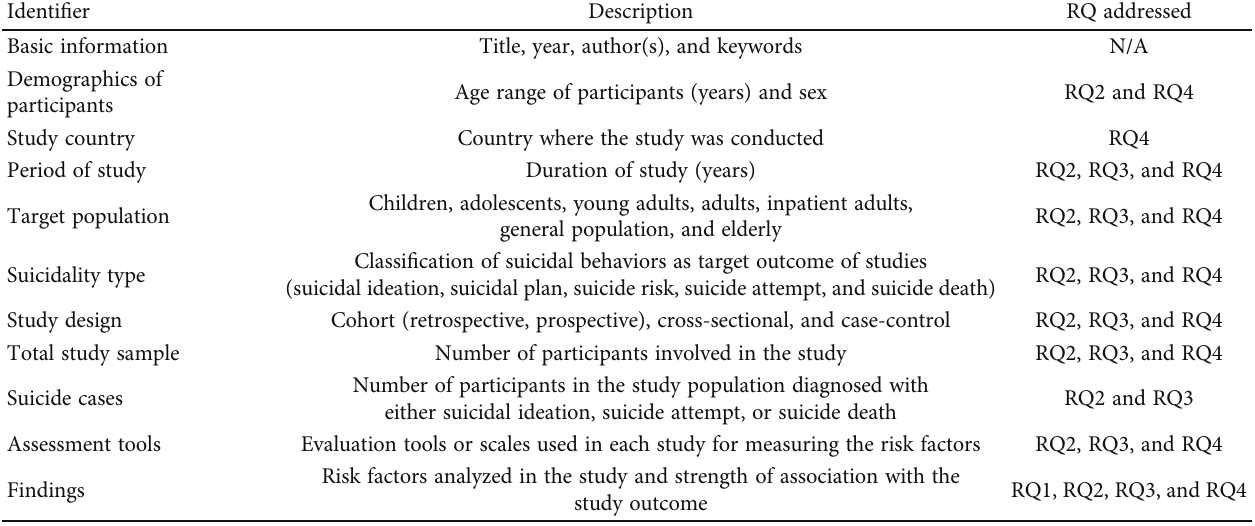
Figure 2: PRISMA fl ow diagram [76] demonstrating the systematic review process undertaken from record identi fi cation to the fi nal pool of included articles. Table 1: Risk factors ’ analysis coding scheme and research question answered by each